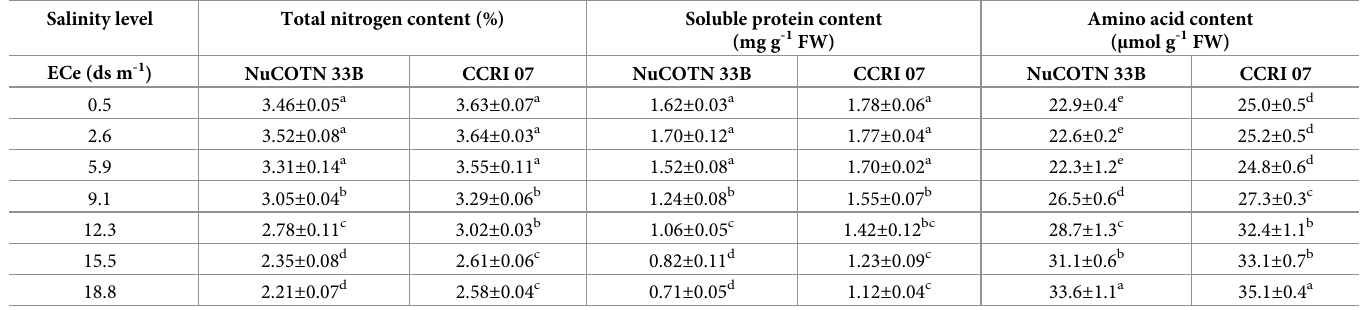
Table 3. Impacts of salinity on total nitrogen, soluble protein and amino acid contents in squares of two Bt cotton cultivars under greenhouse conditions in 2017 (n = 4). Different letters represent significant differences in the same column (Duncan multiple range tests, P < 0.05). Salinity level